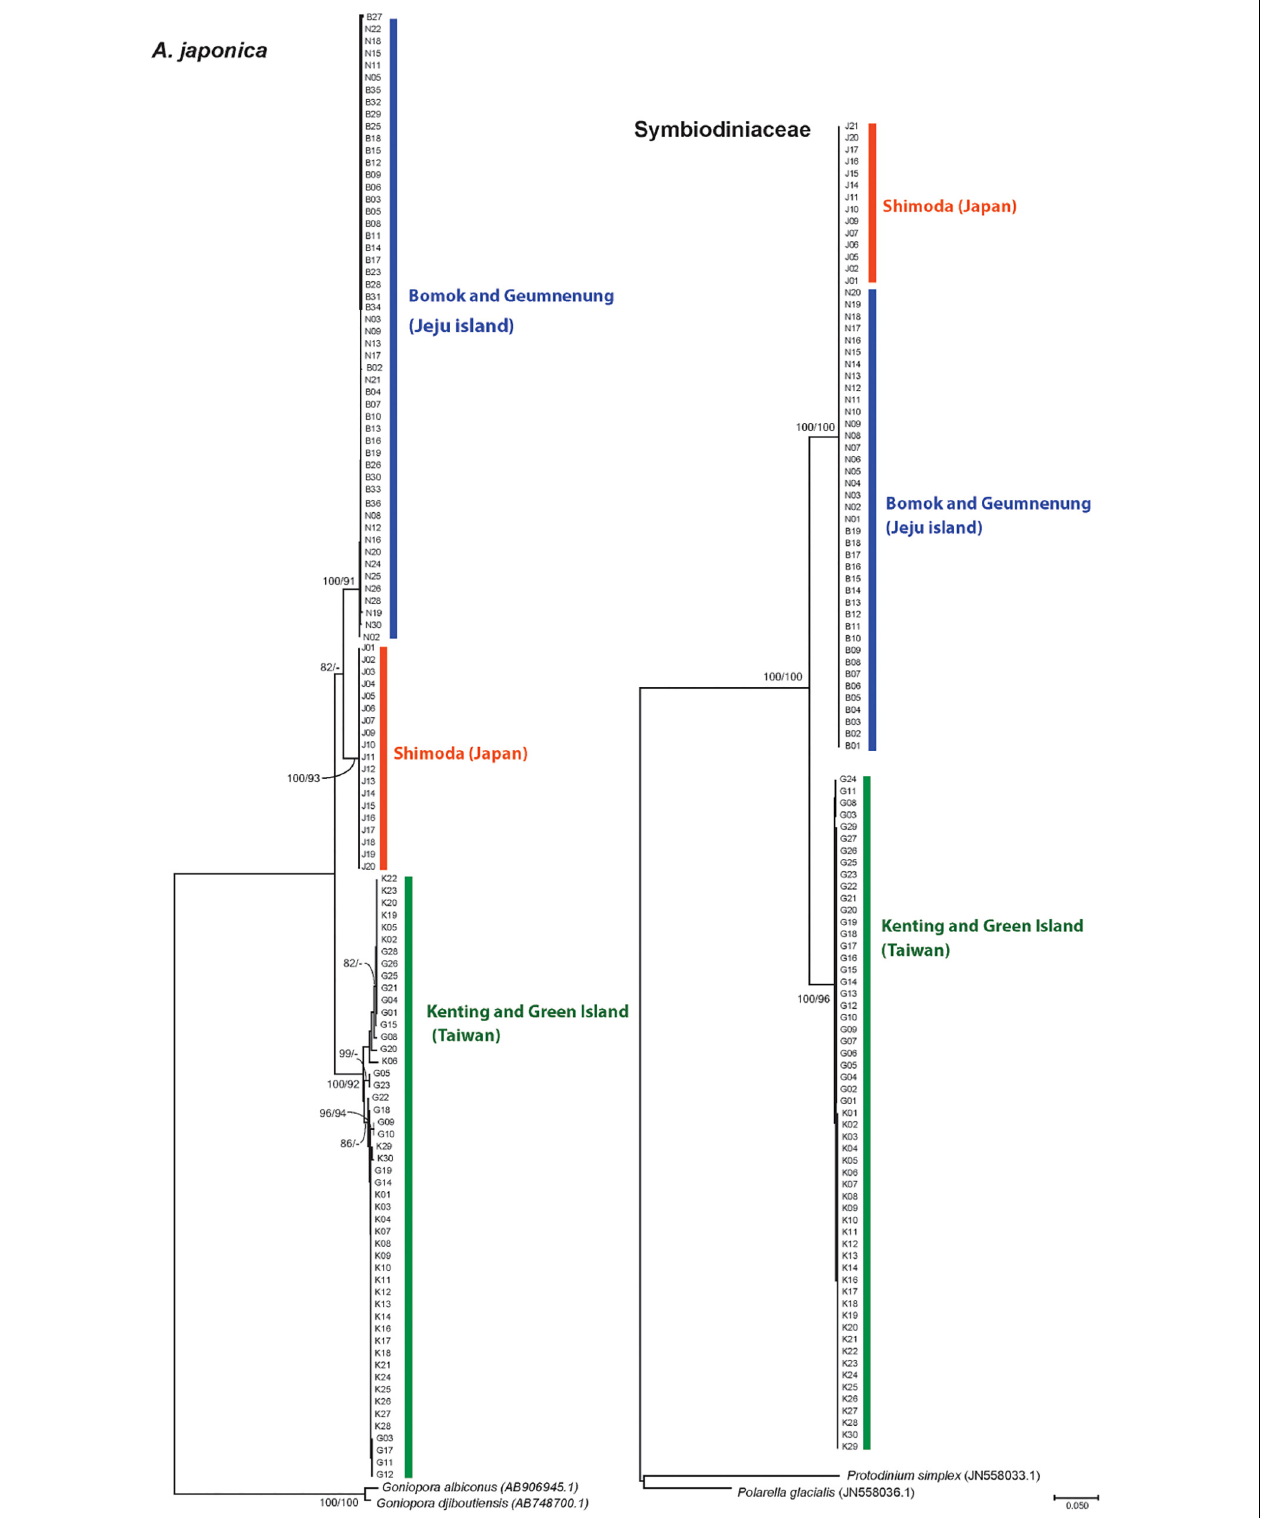
FIGURE 3 | Phylogenetic trees of A. japonica (left, nuclear; ITS, internal transcribed spacer) and Symbiodiniaceae (right, chloroplast 23S rDNA) based on neighbor joining (NJ) and maximum likelihood (ML) methods. The values above the branches represent NJ and ML bootstrap supporting values. The nodes with values < 50% are shown as “ −